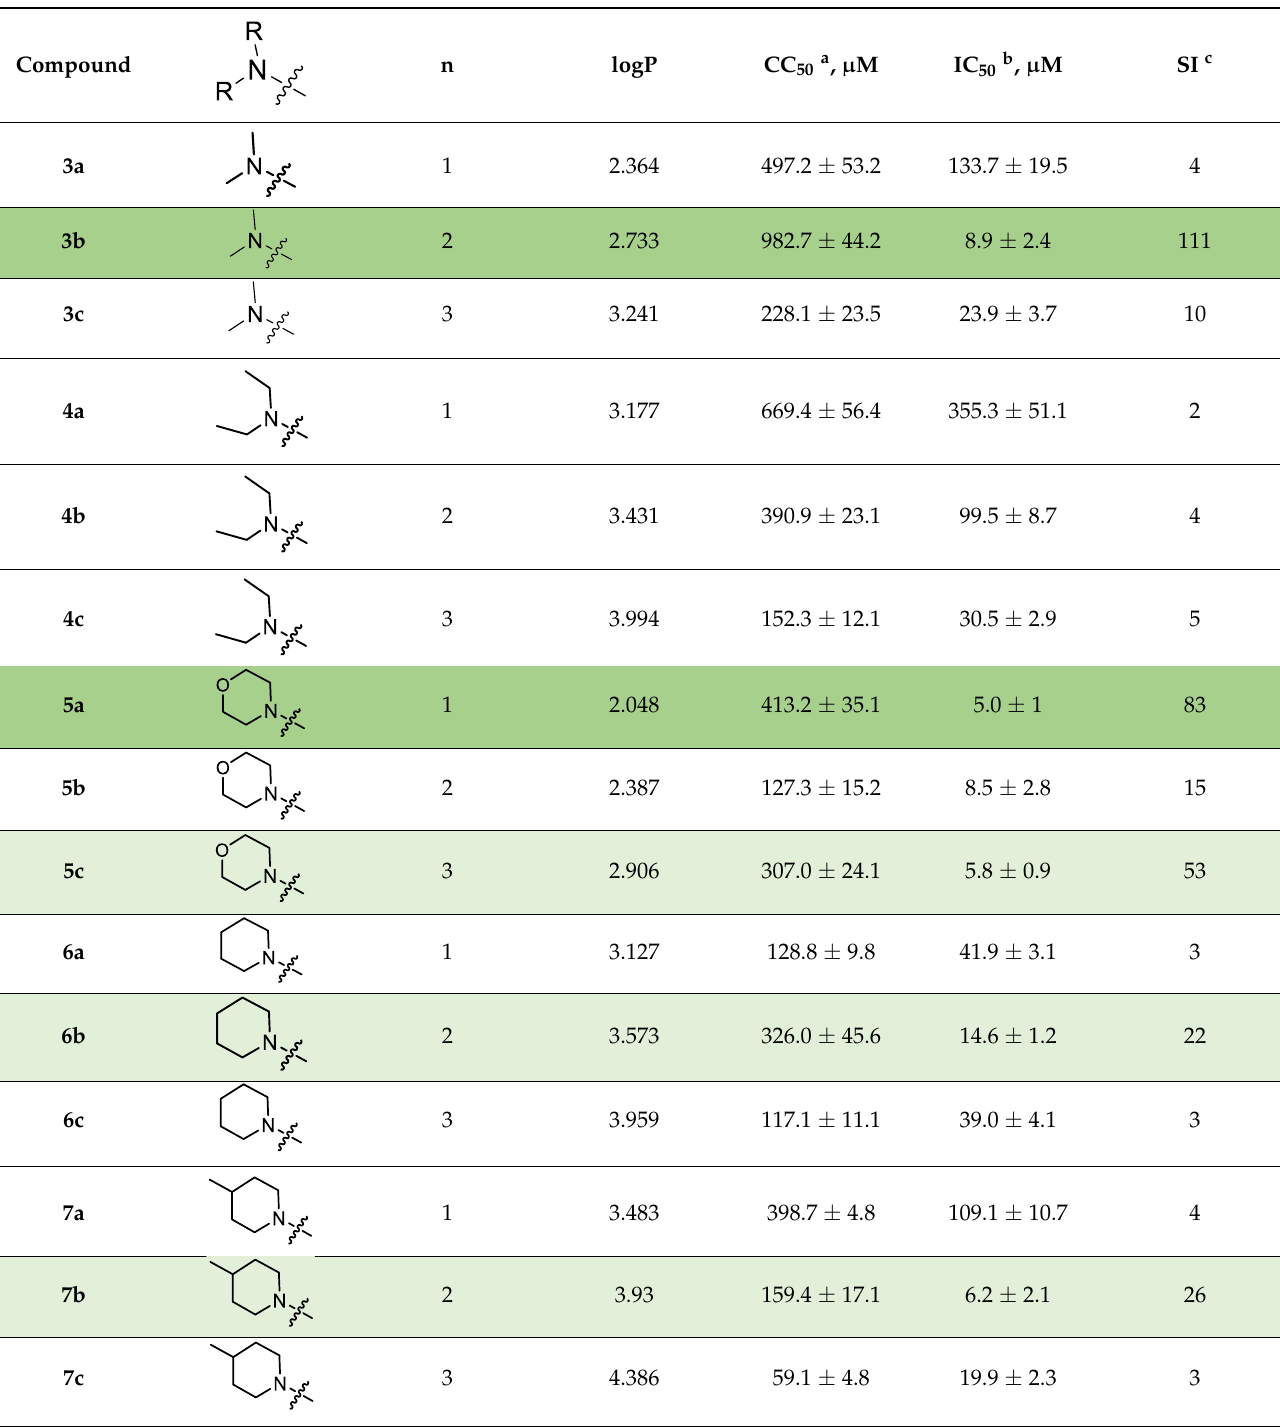
Table 2. In vitro anti-RSV activity, cytotoxicity, and logP values for compounds 3 – 15a – c . Compound